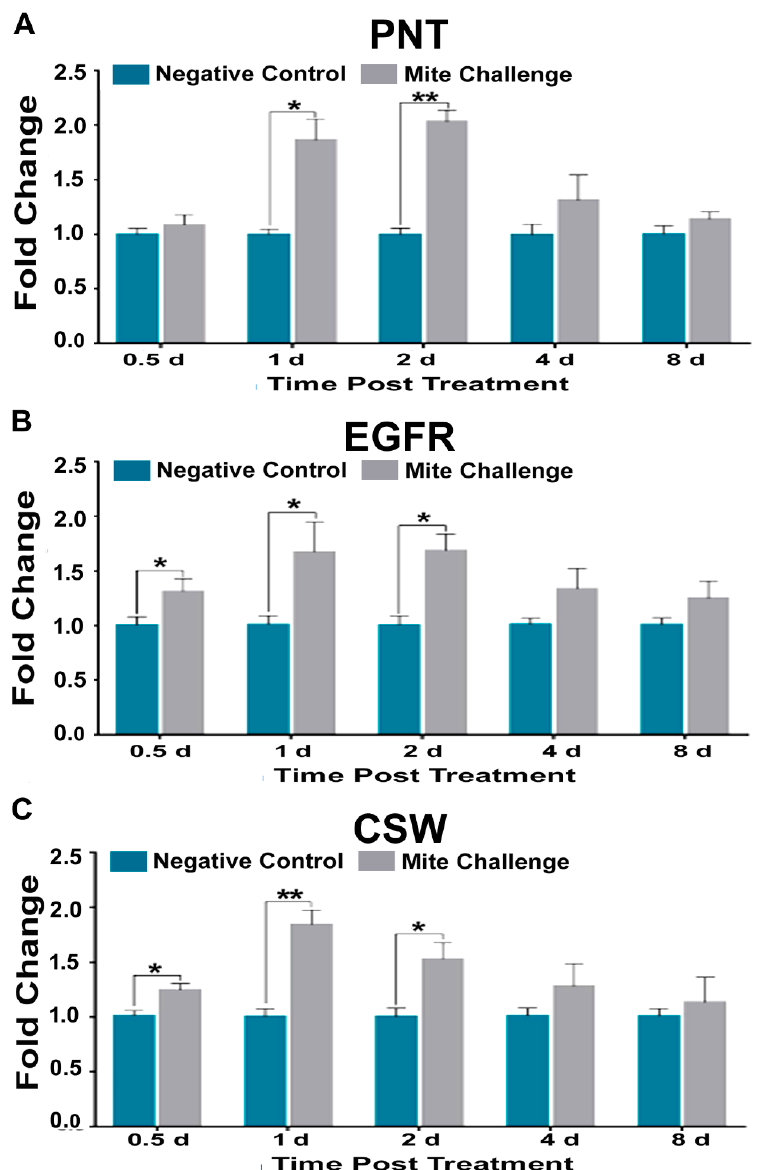
Figure 6. Fold chance of the transcription profiles for parts of cellular proliferation and growth pathway (EGFR) between the negative control (without Varroa challenge) and bees challenged with Varroa mites at different time points post treatment (days). ( A ) growth factor pointed (PNT), ( B ) receptor (EGFR), ( C ) and phosphatase corkscrew (CSW), demonstrating similar expression patterns to Toll pathway components of immunity (* p < 0.05, ** p < 0.01).